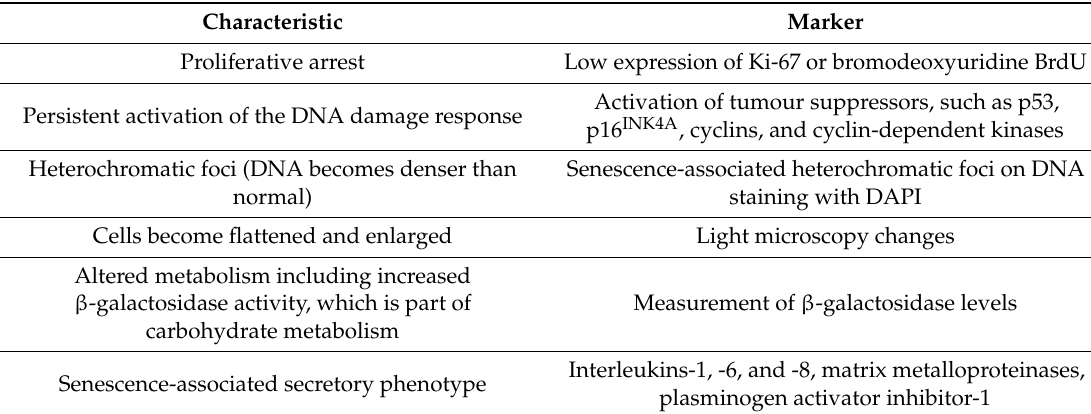
Figure 1. Diagram showing the causal stimuli which may trigger senescence (in yellow) and the effects of senescence on the host tissue (in blue). Table 1. Summary of the key characteristics of senescent cells.